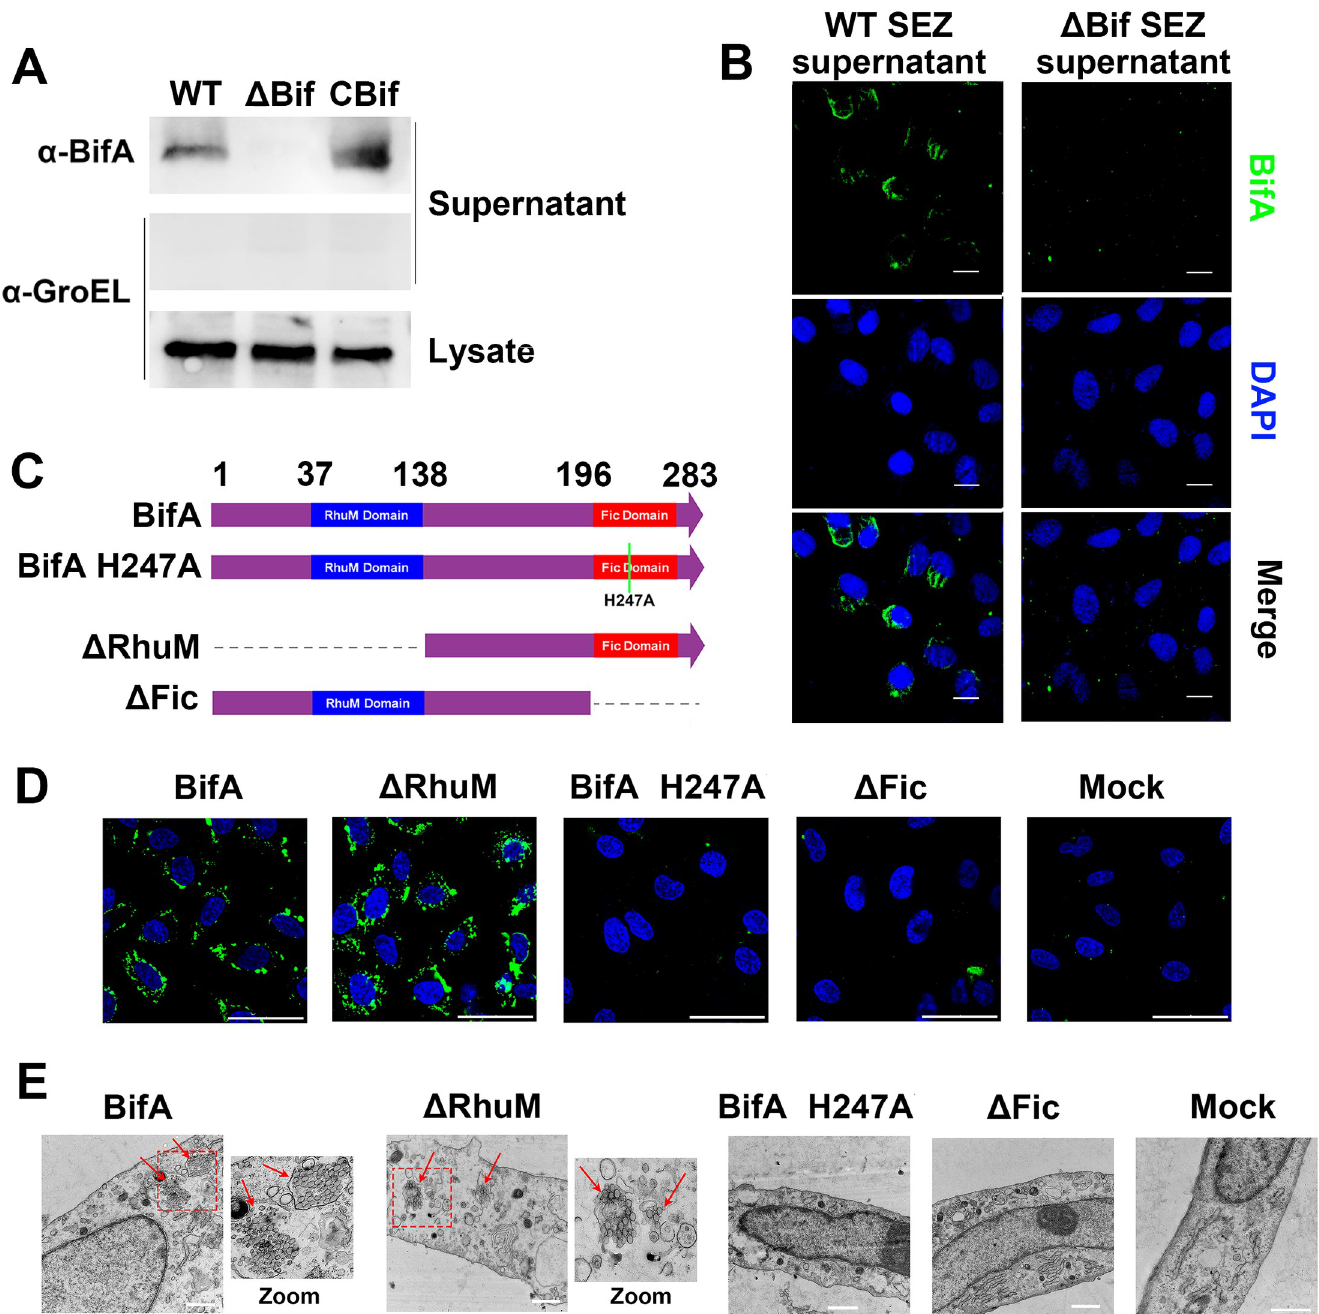
Fig 2. BifA is released into culture supernatants and enters into host cells. (A) Detection of BifA in culture supernatants by western blot. Immunoblots were performed with anti-BifA polyclonal antibody. Immunoblots of supernatants with antibody against GroEL, a cytosolic protein, were also performed to check for cytosolic contamination of supernatants and of bacterial lysates as a loading control. (B) Immunofluorescence microscopy of hBMECs incubated with supernatants from WT or Δ Bif SEZ. BifA was detected by immunostaining with anti-BifA antibody (green) and DAPI was used as a counterstain for nuclei (blue) (scale bar = 10 μ m). (C) Diagram of wild type and variant BifA proteins purified for experiments in ( D ) and ( E ). (D) Immunofluorescence microscopy of hBMECs that had been incubated with indicated BifA variants. BifA was detected by immunostaining (green) and DAPI was used as a counterstain for nuclei (blue). Images represent merged fluorescence channels (scale bar = 50 μ m). (E) Transmission EM of hBMECs that had been incubated with latex beads coated with indicated BifA variants. For mock, cells were incubated with uncoated latex beads. Dashed boxes indicate areas of higher magnification (shown on right for BifA and Δ RhuM). Arrows indicate internalized latex beads (scale bar = 1 μ